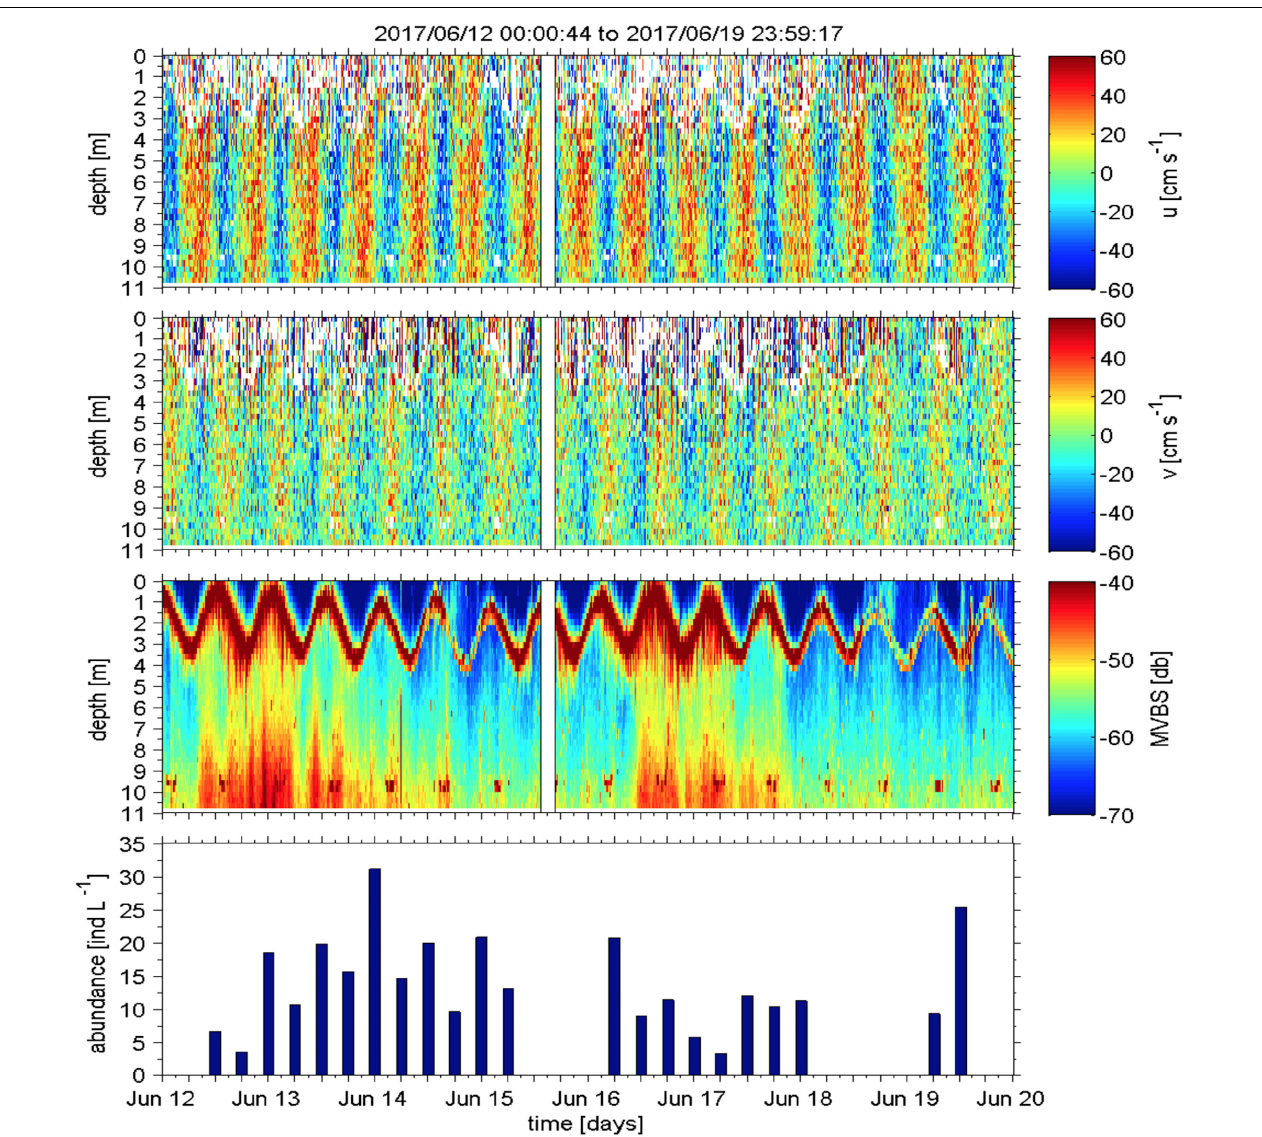
FIGURE 8 | An 8-day sample (2017/06/12 00:00 to 2017/06/20 00:00) of horizontal velocity components u and v as well as backscatter estimated from the ADCP, moored about 500 m north of the island of Helgoland at a depth of around 10 m at the AWI underwater experimental field “Margate.” The lowermost panel shows the total abundance of plankton and particles derived from the VPR measurements (no data = underwater maintenance work at the observatory).